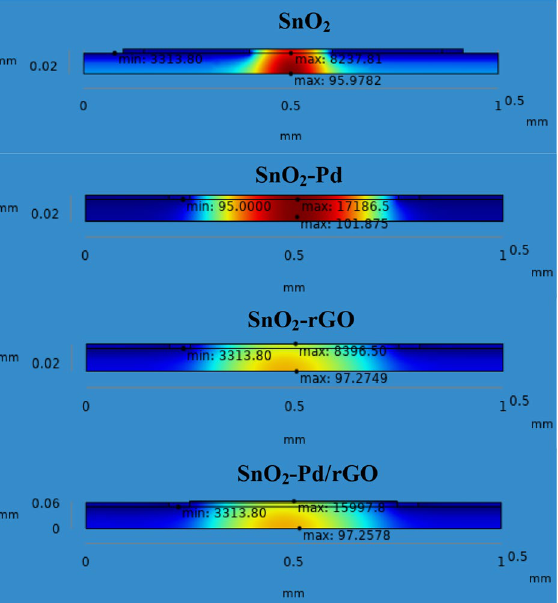
Figure 11. 3D Simulation NO x sensing enthalpy flow over thin film chemical gas sensor: ( a ) SnO 2 , ( b ) SnO 2 – Pd, ( c ) SnO 2 –rGO and ( d ) SnO 2 –Pd/rGO.